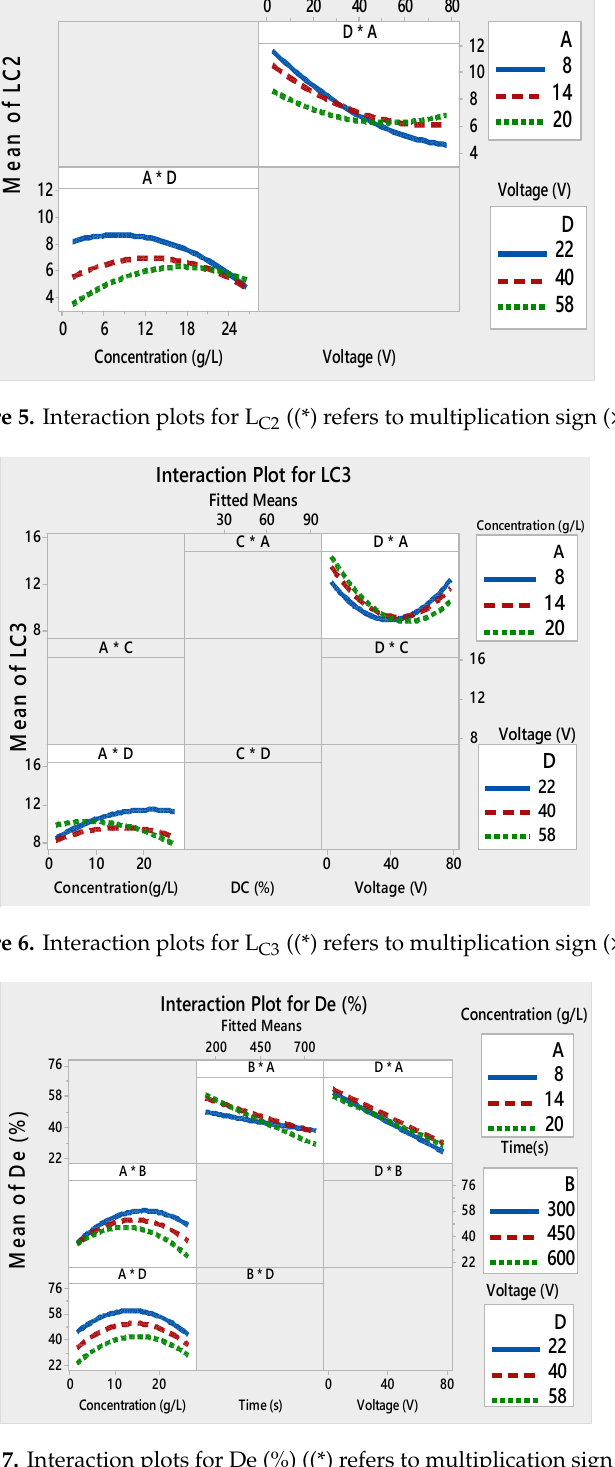
Figure 7. Interaction plots for De (%) ((*) refers to multiplication sign (×)).